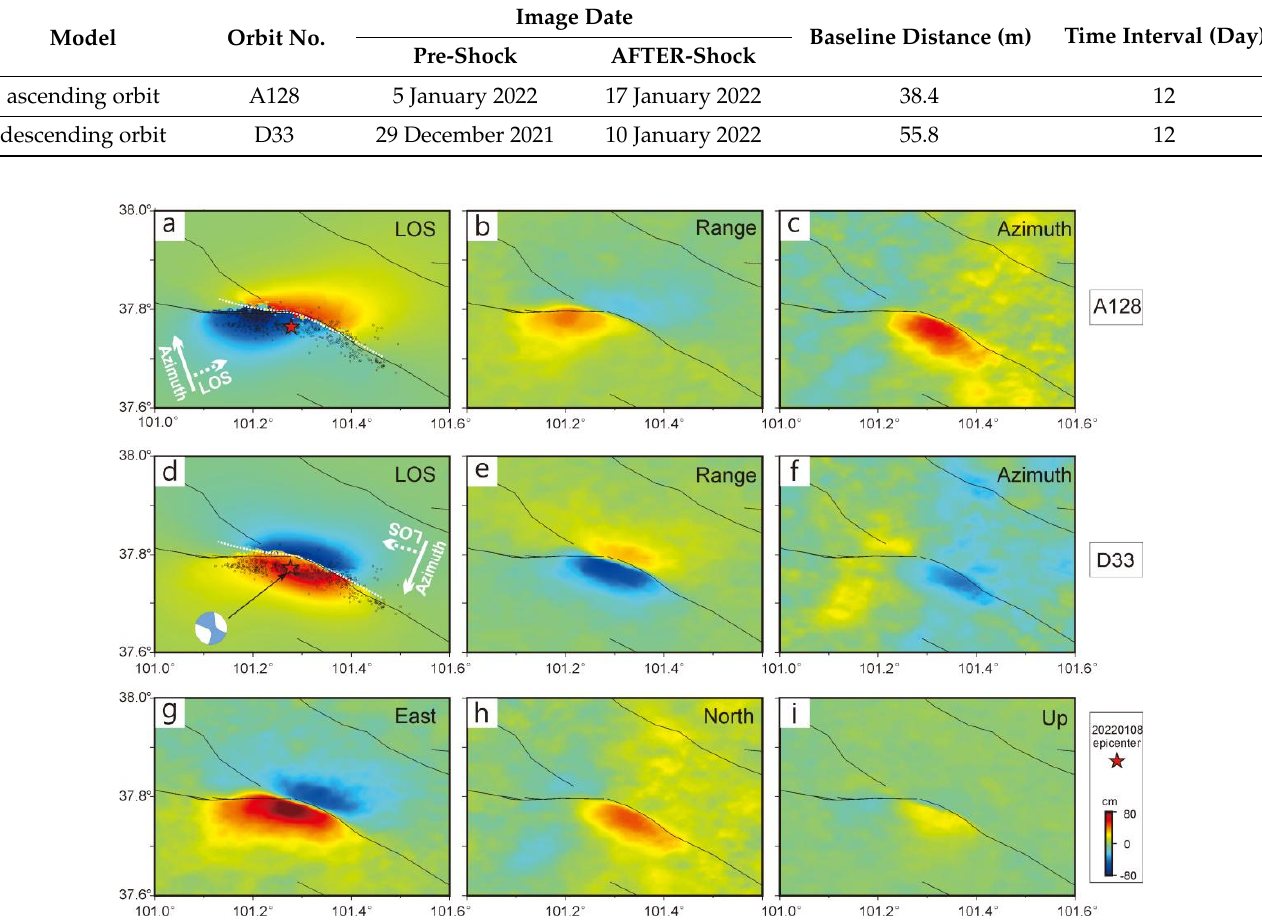
Table 2. Parameters of SAR interferograms.